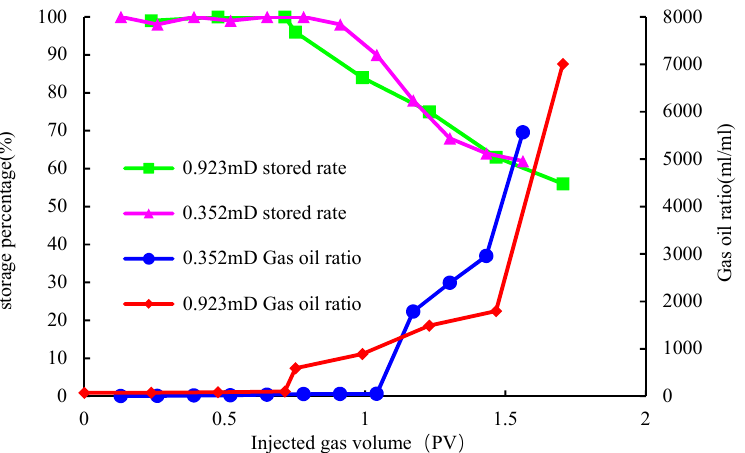
At the same storage percentage, the recovery factor of crude oil from a high perme- ability core is higher. The storage percentage decreases with the increase of the recovery factor. When the 0.352 mD core experiences gas channeling, the storage percentage is about 68%. When 0.923 mD rock core experiences gas channeling, the storage percentage is lower, at around 63%. Therefore, a low permeability reservoir rock is more capable of storing CO 2 (Figure 6). This is the case after a threshold recovery factor which is between 45% to 50% for the studied cores. Below that threshold, the storage percentage is not sensitive to the recovery factor or the permeability of